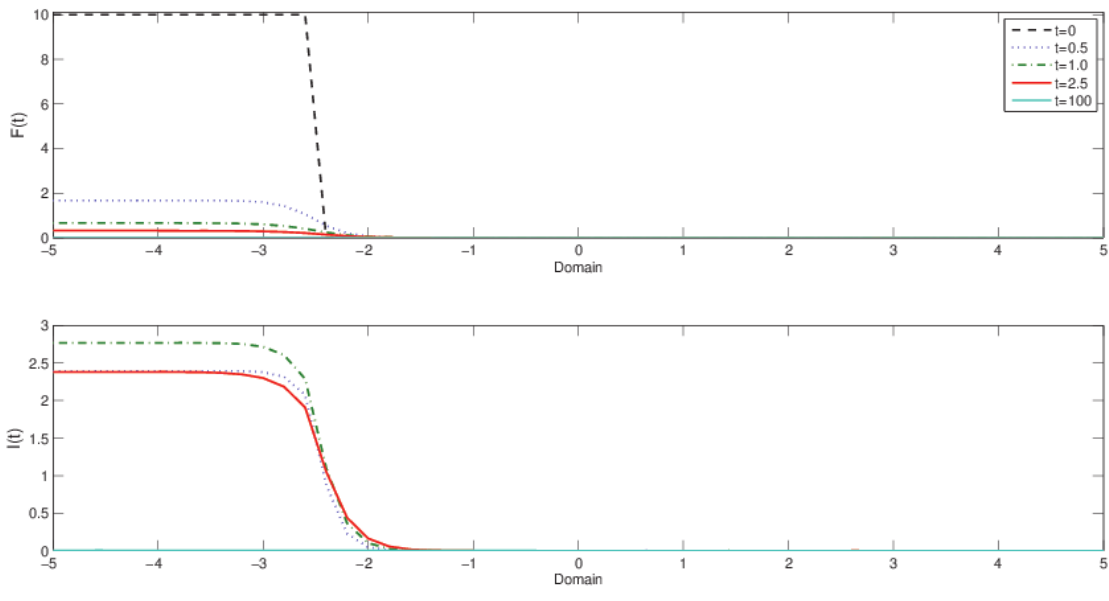
Fig. 9. The parameter values in Table VII do not satisfy condition for asymptotic stability of the PFE , however convergence to PFE is